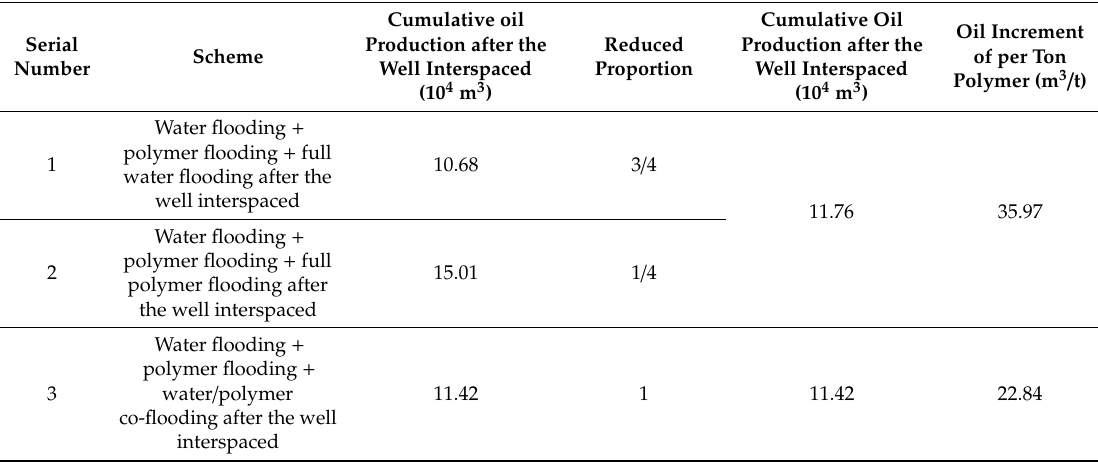
Table 3. The designed